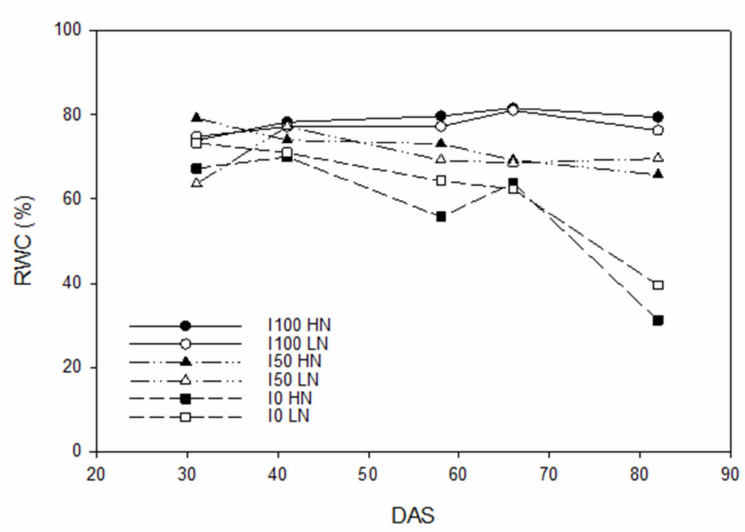
Figure 2. Variation in the relative water content (RWC) during the growing season of sweet maize for different water and nitrogen treatments.